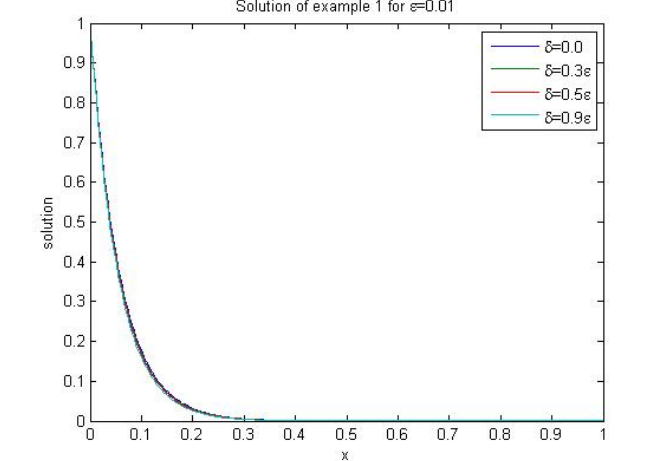
Figure 1. Numerical solution of Example 1 with different values of 𝜹 with 𝜺 =0.01